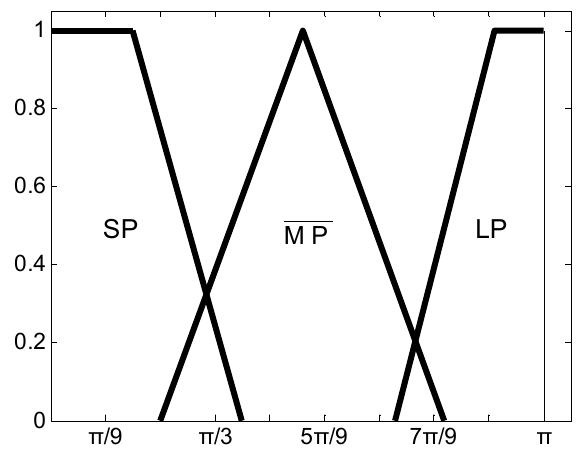
Figure 6. Membership functions of fuzzy sets in field angle B k .